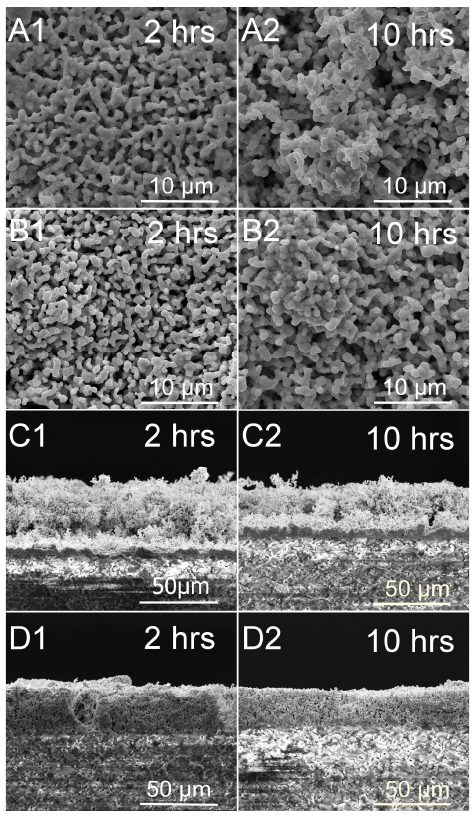
Figure 2. SEM surface and cross-sectional images of ITO and In 2 O 3 films without glass additives annealed at 1250 °C with different measuring times. ( A , C ) ITO film; ( B , D ) In 2 O 3 film.